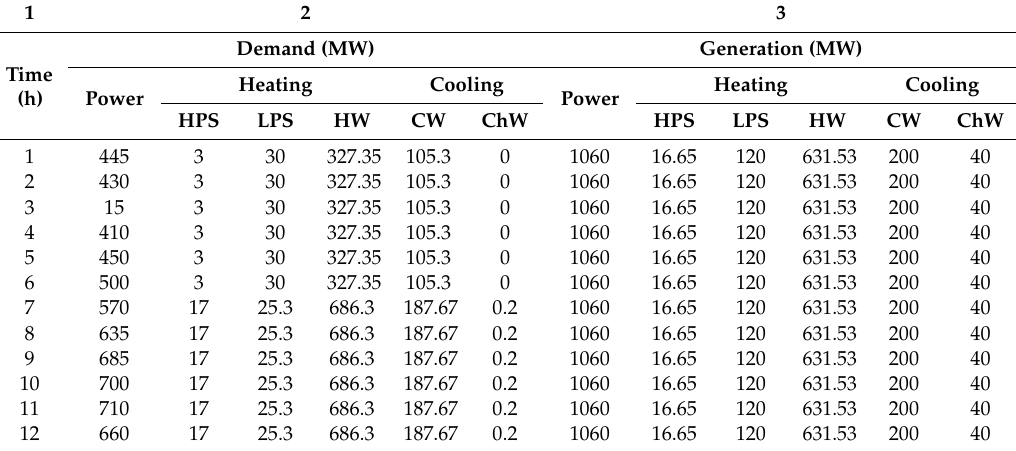
Table A1. TriGenSCA before iteration from time 1 to 12 h.